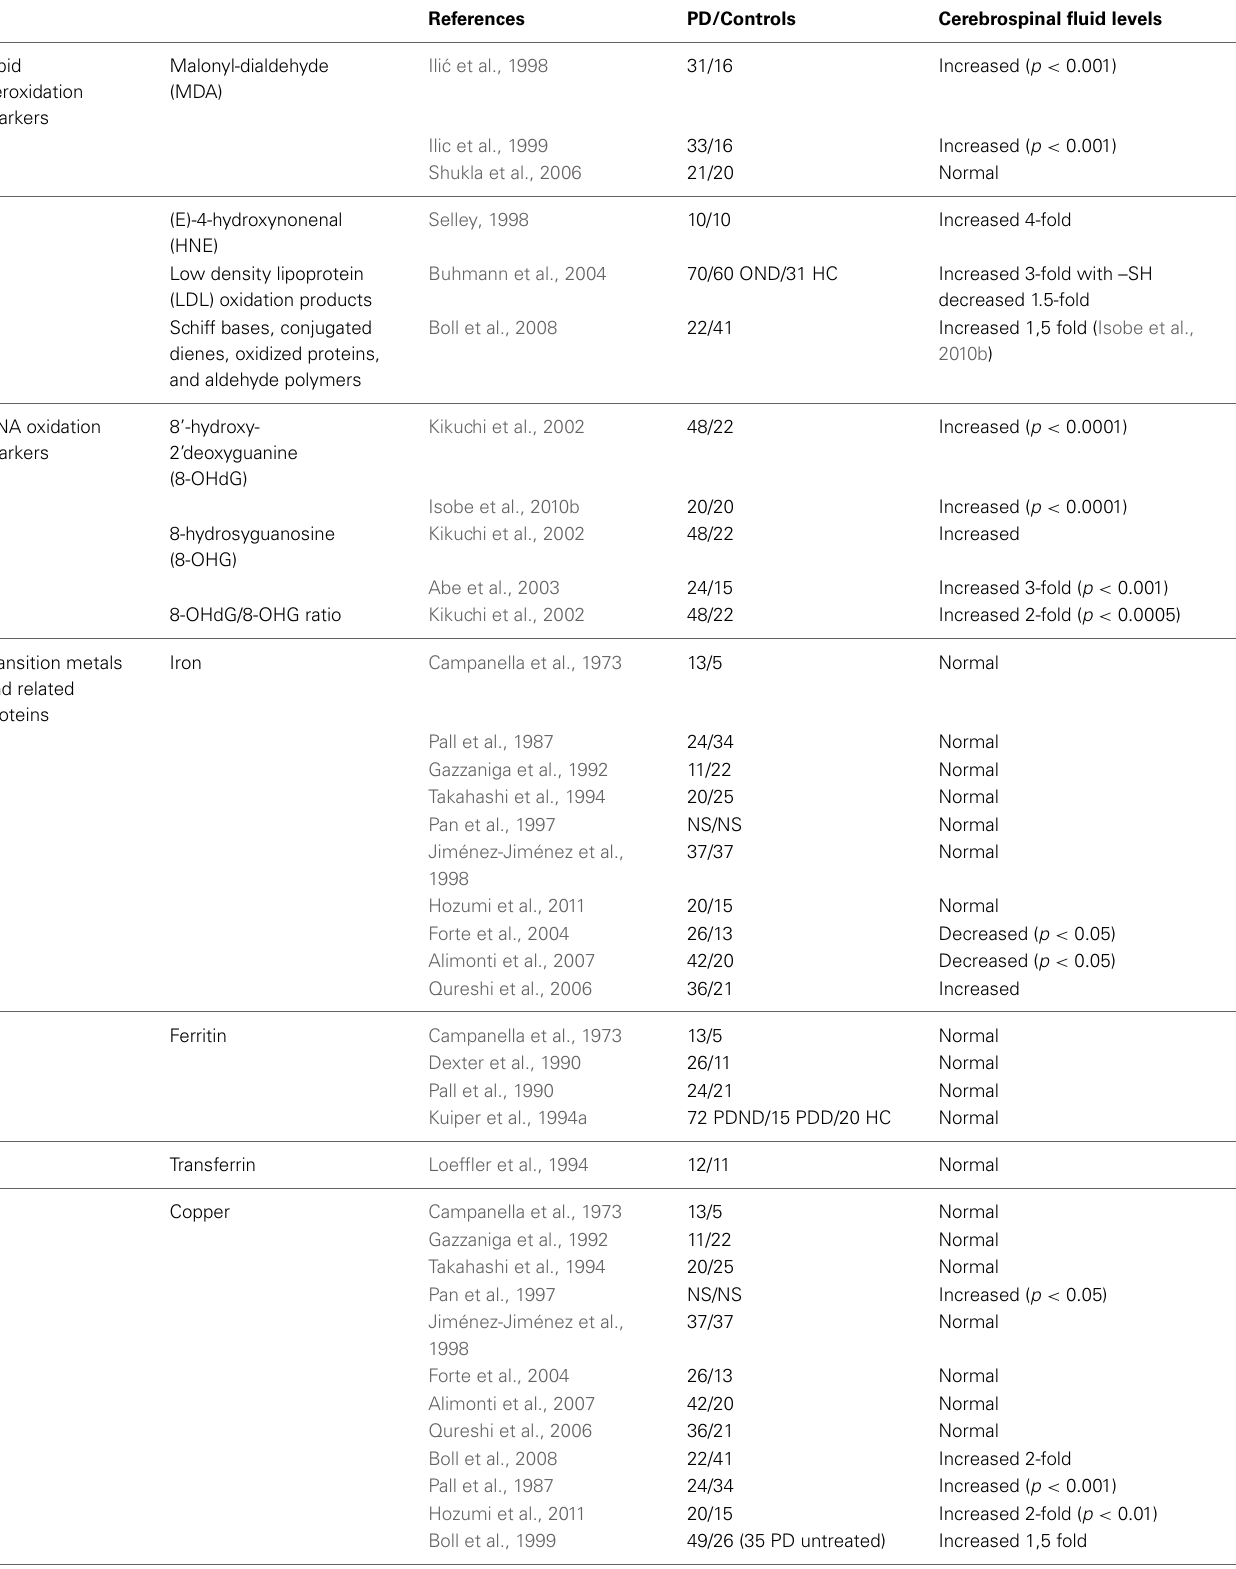
Table 3 | Alterations in the CSF levels of oxidative stress markers and substances related with oxidative stress in PD patients compared with